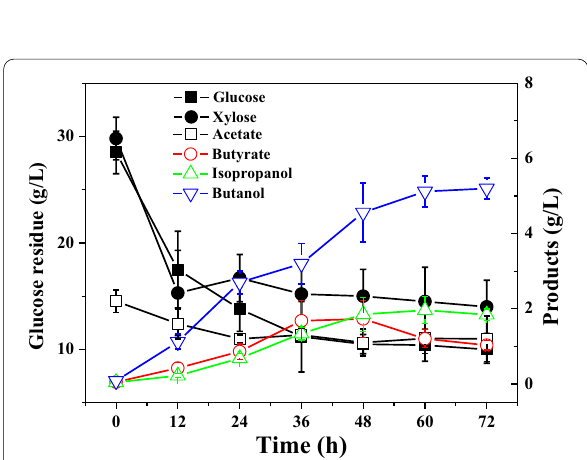
Fig. 3 BI fermentation by C. beijerinckii XH0906 in P2 medium with glucose and xylose